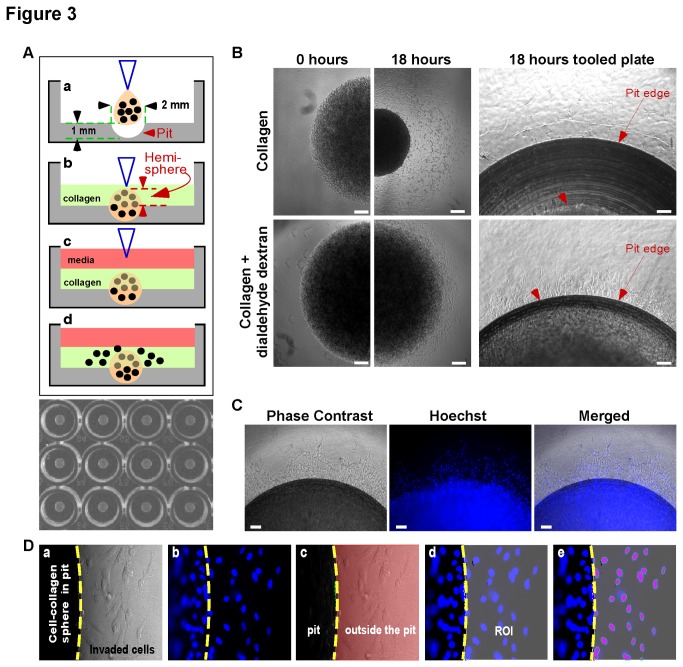
Standardization and automation of the 3-D invasion assay.A) Schematic diagram (top panel) of the 3-D invasion assay with tooled plate: (a) The cell-collagen mixture is dotted into the 2 mm in diameter pits in the center of each well of the tooled 96-well plate, creating spheres that occupy a volume of 4.18 mm3; (b) protruding cell-collagen hemispheres are covered with collagen; (c) medium containing compounds is added and plate is incubated for 18 hours; and (d) invaded cells beyond pit boundary are counted. Black dots represent cells. Diagram not to scale. An image of a section of a tooled plate with a pit in the center of each well is shown (bottom panel). B) Inhibition of collagen contraction via dialdehyde dextran: HT1080 cells were mixed with collagen with or without the addition of dialdehyde dextran before overlaying with collagen. Phage contrast images were taken at time 0 and 18 hours (left panel, Scale bar = 250 μm) and 18 hours in the tooled plate (right panel, Scale bar = 100 μm). Red arrows indicate the edge of the pits. Red arrowheads indicated the edge of the cell-collagen spheres. C) Phase contrast and fluorescent images of invaded HT1080 cells in the tooled plate stained with Hoechst dye. Scale bar = 100 μm. D) Automated quantification: Both phase contrast and fluorescent images (a & b) of HT1080 cells following invasion were acquired using a Nikon TE-2000s controlled by the NIS Elements imaging software. A threshold of the phase contrast image of the first well was adjusted based on the contrast to create two binary layers, one inside the pit (highlighted in black) and one outside of pit (highlighted in pink) (c). The binary layer outside the pit (pink area) was copied to form a region of interest (ROI), which was then applied to the Hoechst image (d). The invaded cells within the ROI were then automatically counted with the counted cells appearing purple in color (e).